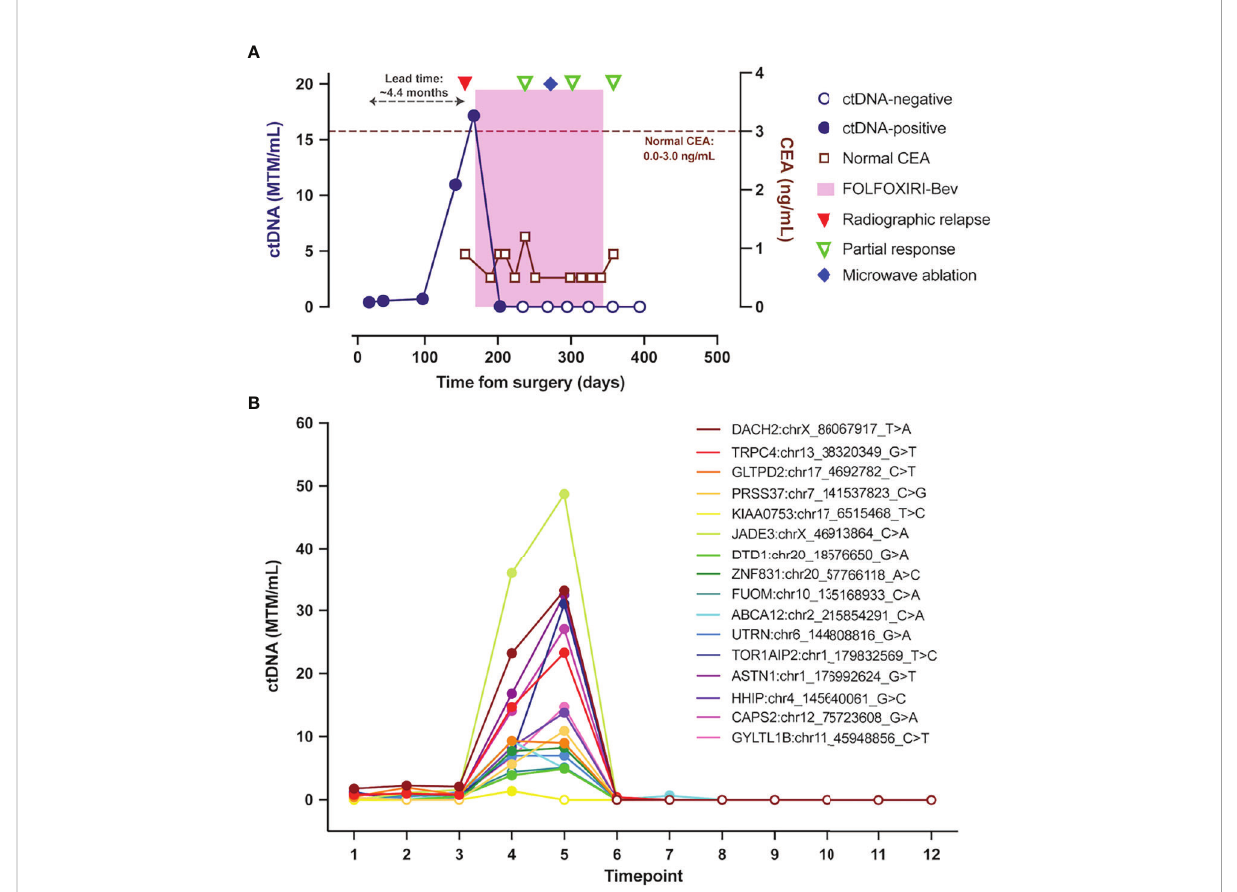
FIGURE 2 ctDNA dynamics throughout the clinical course. (A) Overview plot depicting composite ctDNA changes as measured in MTM/mL, along with radiographic imaging and therapeutic interventions. (B) Changes in levels of patient-speci fi c variants identi fi ed and tracked using Signatera ™ Molecular Residual Disease Test. ctDNA, circulating tumor DNA; MTM/mL, mean tumor molecules per milliliter of